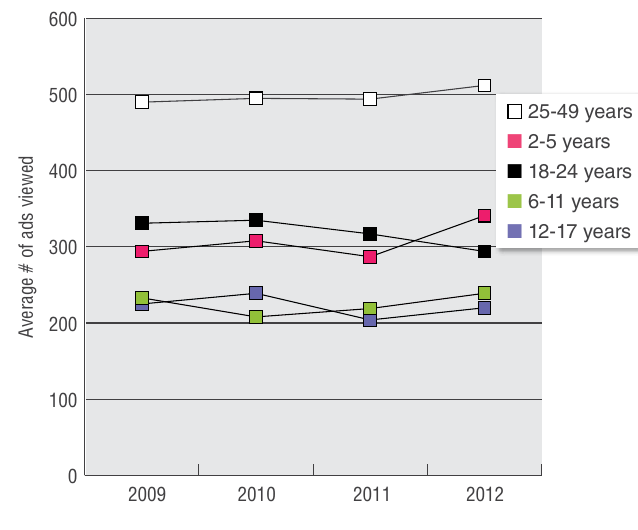
Figure 15. Trends in exposure to TV advertising on Spanish- language TV by age group